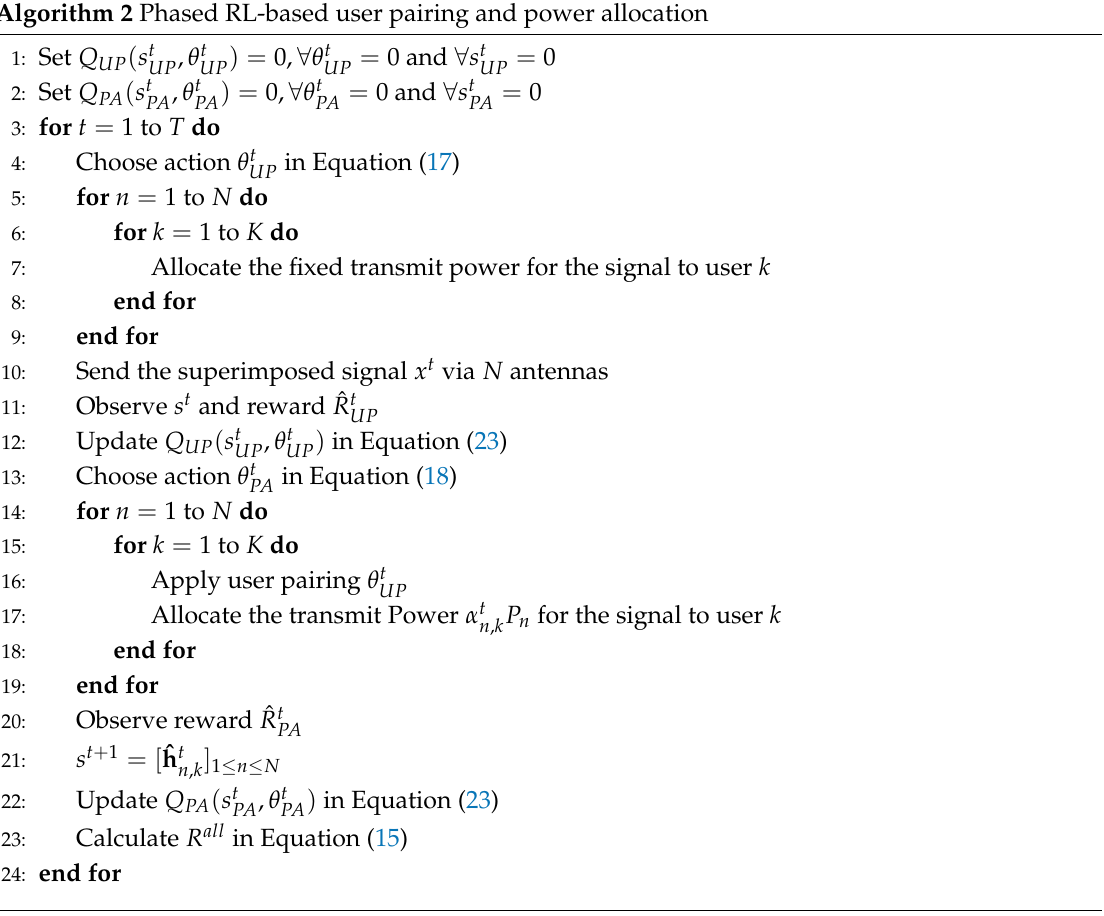
Algorithm 2 Phased RL-based user pairing and power